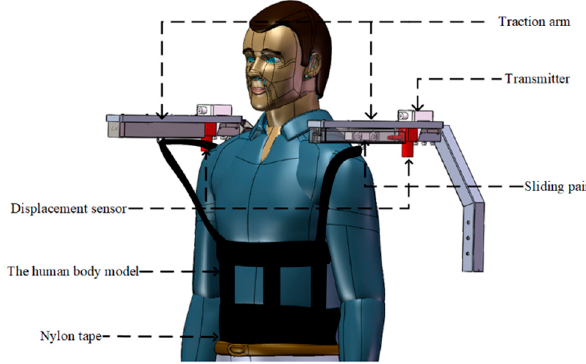
Figure 3. Human-computer interaction system of robot.